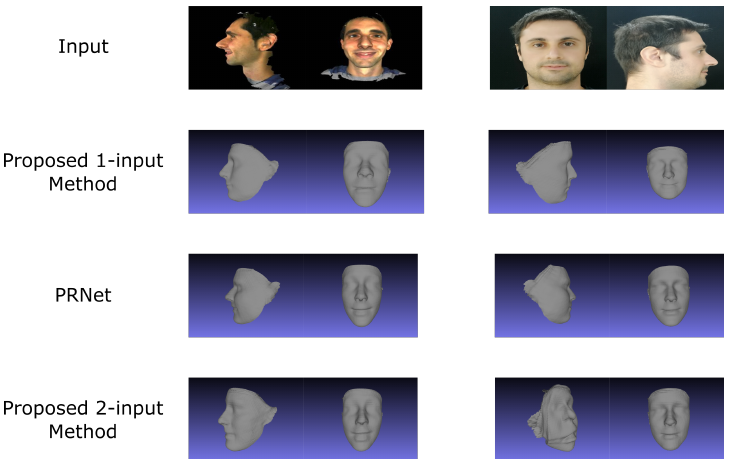
Figure 23. Reconstruction results from different models. The image to the left is from MICC Florence, and the one on the right is from a proprietary NTNU dataset.